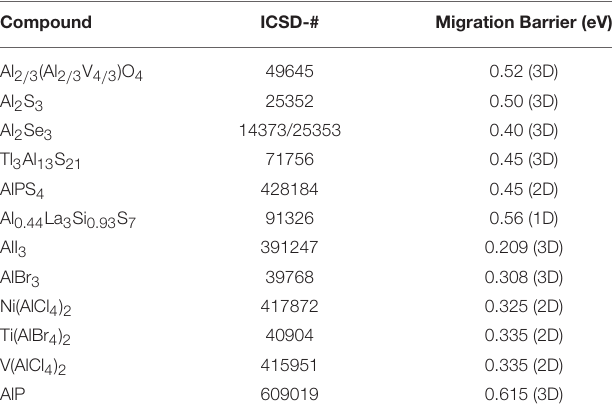
TABLE 3 | Promising materials as positive electrodes or solid electrolytes for rechargeable aluminum-ion batteries. Compound